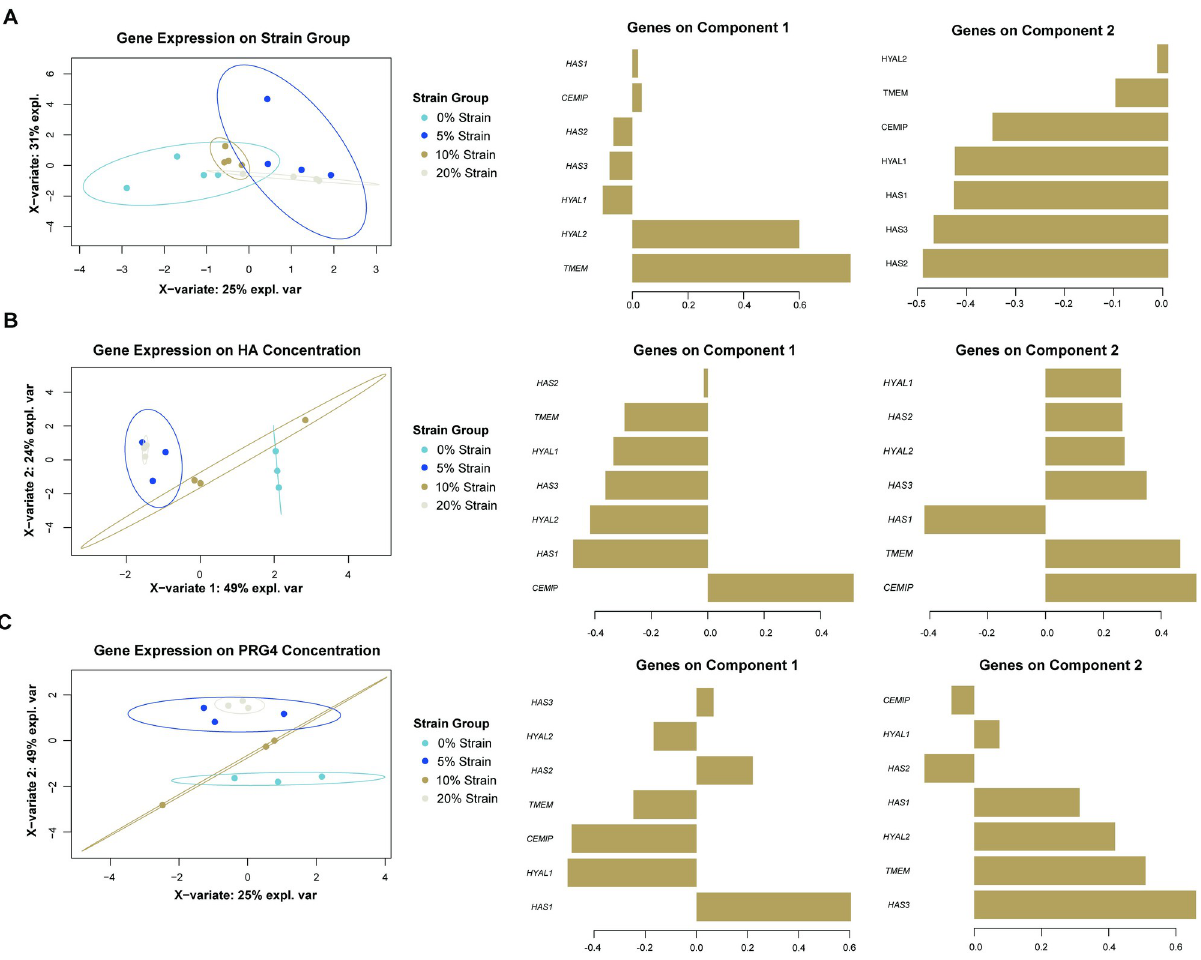
Fig 5. Substrate stiffness and strain magnitude display distinct cytokine concentration profiles in conditioned media. A) Values shown are mean percent difference cytokine concentrations of loaded media samples compared to the TCP group. B) Values shown are mean percent difference cytokine concentrations of loaded media samples compared to the 0% strain group (blue indicates a percent decrease, red indicates a percent increase). C) Sparse PCA of cytokine concentration with each sample grouped by strain group, along with corresponding loadings plots. sPCA is shown as a scatter plot in the X-Y representative space of the gene expression data along PC1 and PC2, which explain over 99% of the variation in the